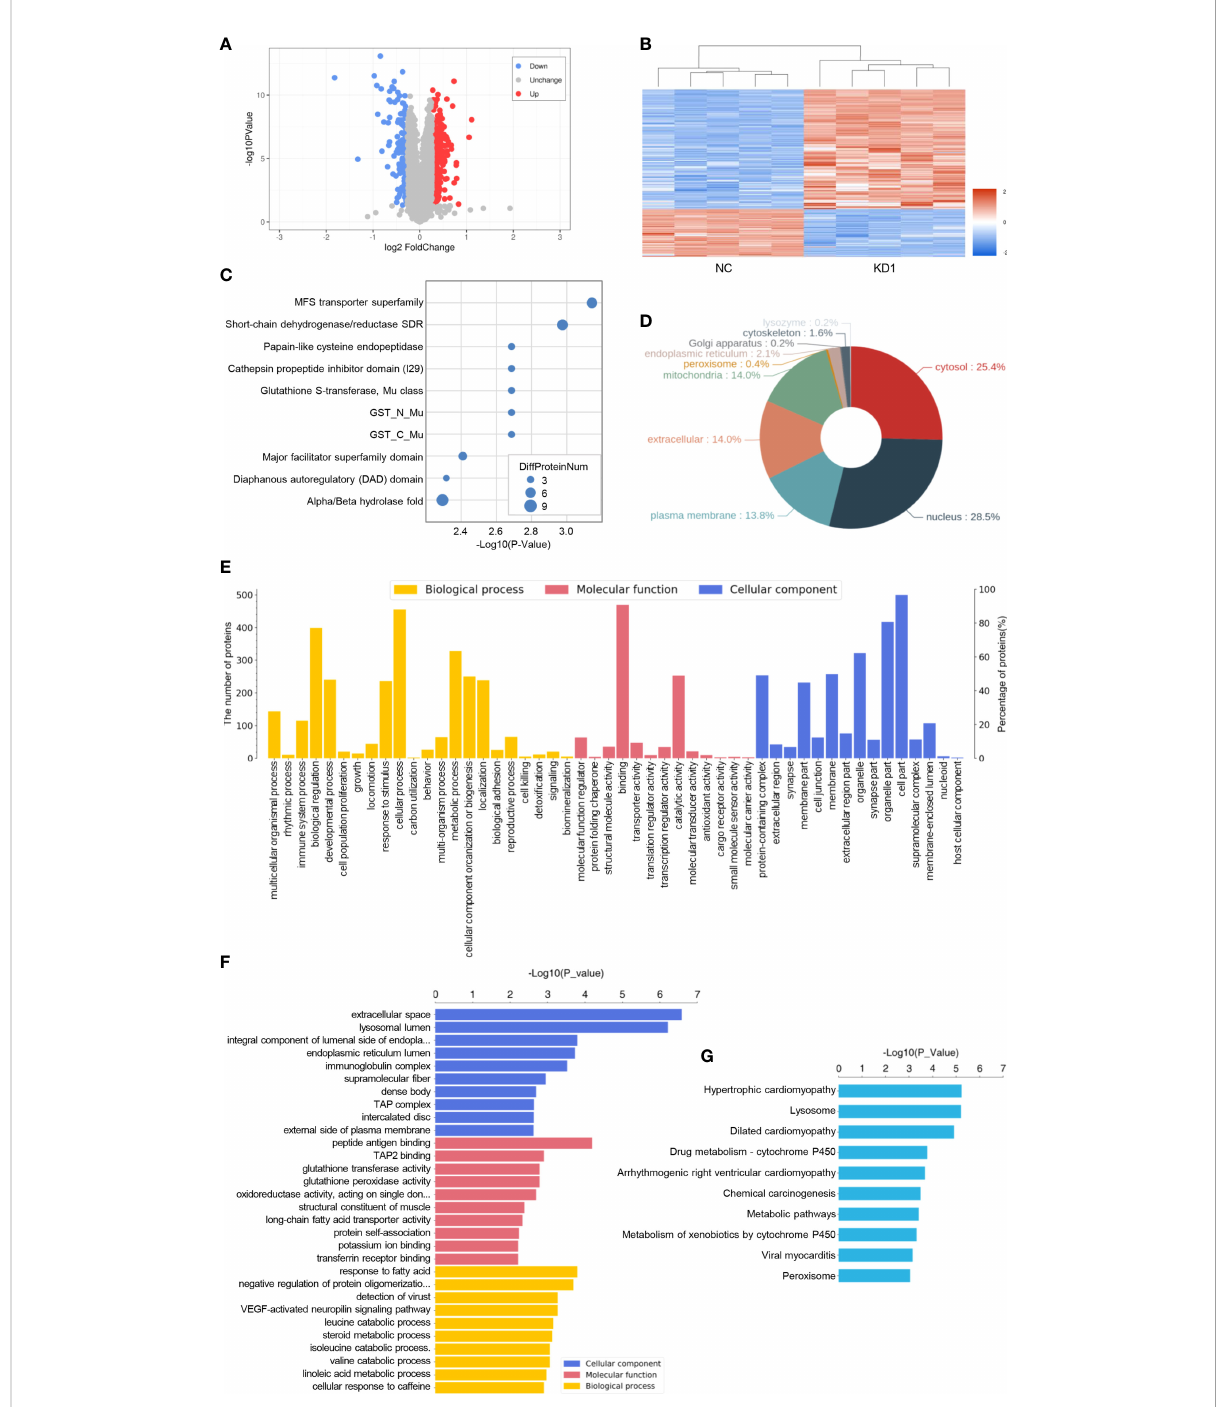
FIGURE 7 Proteomic analysis of A2780 cells with the interference of La. (A) The volcano map of differentially expressed proteins. The blue circle on the left represents the number of downregulated proteins, and the red circle on the right represents the number of upregulated proteins. Abscissa is the difference multiple (logarithmic transformation with 2 as the base). The ordinate is the value of P (logarithmic transformation based on 10). (B) Cluster analysis of differentially expressed proteins. (C) Statistical bubble chart (top 10) of protein domains with signi fi cant enrichment. (D) Protein subcellular localization map. (E) Level 2 statistical histogram of GO annotation. (F) The statistical histogram of the GO term with signi fi cant enrichment (top 10). The ordinate represents the name of Go function, and the abscissa represents the P value of enrichment signi fi cance. (G) Statistical histogram of the KEGG pathway with signi fi cant enrichment (top 10). The ordinate represents the name of the KEGG pathway, and the abscissa represents the P value of enrichment signi fi